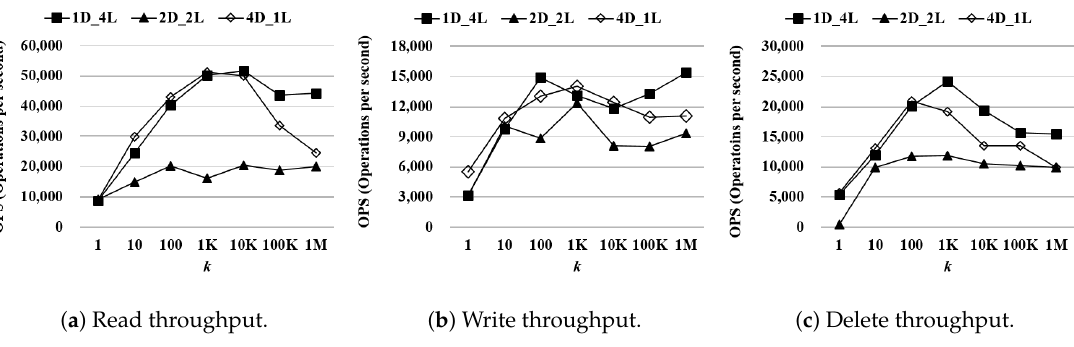
Figure 8. Performance of WR-Store as WR D and WR L are varied. ( a ) Read throughput; ( b ) Write throughput; ( c ) Delete throughput.